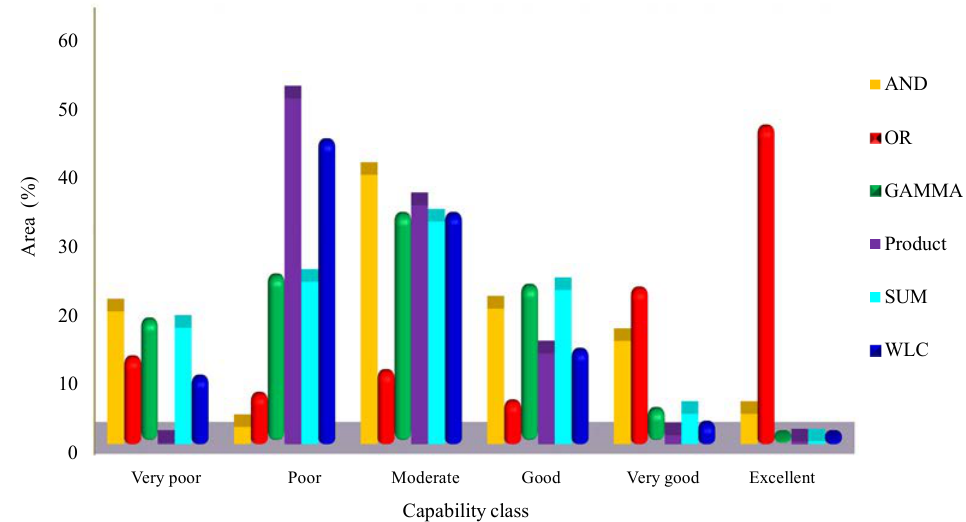
Fig. 8: Histograms of fuzzy operators reclassifications: a) AND; b) OR; c) GAMMA; d) PRODUCT; e) SUM; f)